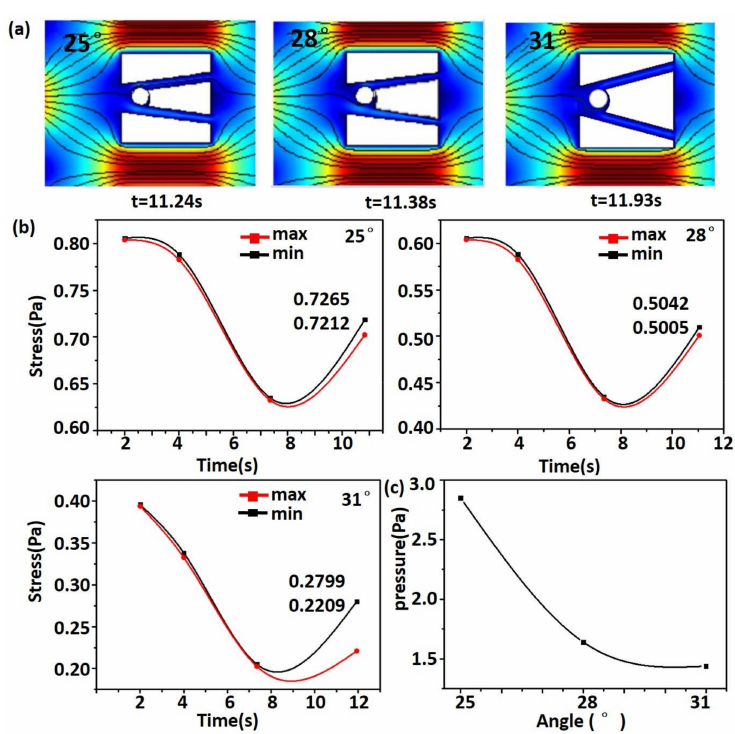
Figure 5. ( a ) The final capture of the microsphere in different angles; ( b ) The stress of the microsphere in different angles; ( c ) The fluid pressure in different angles.